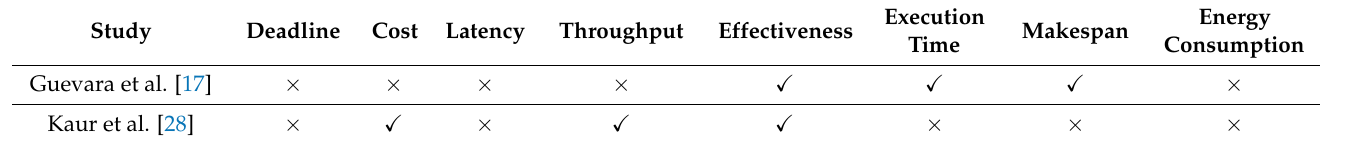
Table 3. Analysis of articles in terms of evaluation parameters in urban computing